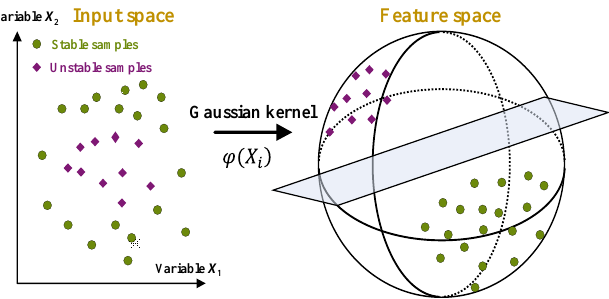
Figure 5. Principal diagram of SVM kernel function.